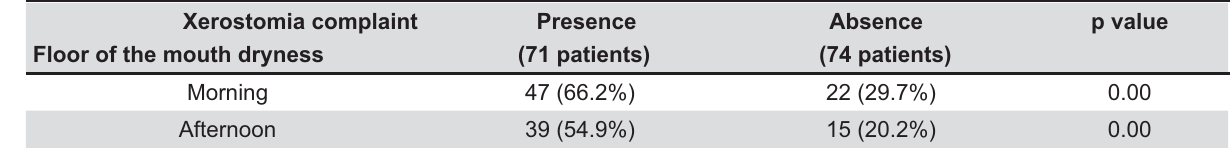
Table 3- (cid:4)(cid:30)(cid:14)(cid:12)(cid:23)(cid:16)(cid:17)(cid:11)(cid:15)(cid:4)(cid:29)(cid:14)(cid:16)+(cid:14)(cid:14)(cid:15)(cid:4)((cid:14)(cid:19)(cid:11)(cid:18)(cid:16)(cid:11)W(cid:17)(cid:23)(cid:4)(cid:9)(cid:11)W)(cid:12)(cid:23)(cid:17)(cid:15)(cid:16)(cid:4)(cid:23)(cid:15)*(cid:4)(cid:16)(cid:11)(cid:16)(cid:23)(cid:12)(cid:4)(cid:15)(cid:28)W(cid:29)(cid:14)(cid:19)(cid:4)(cid:11)(cid:13)(cid:4))(cid:23)(cid:16)(cid:17)(cid:14)(cid:15)(cid:16)(cid:18)(cid:4)+(cid:17)(cid:16)(cid:10)(cid:4)^(cid:11)(cid:11)(cid:19)(cid:4)(cid:11)(cid:13)(cid:4)(cid:16)(cid:10)(cid:14)(cid:4)W(cid:11)(cid:28)(cid:16)(cid:10)(cid:4)*(cid:19)(cid:20)(cid:15)(cid:14)(cid:18)(cid:18)